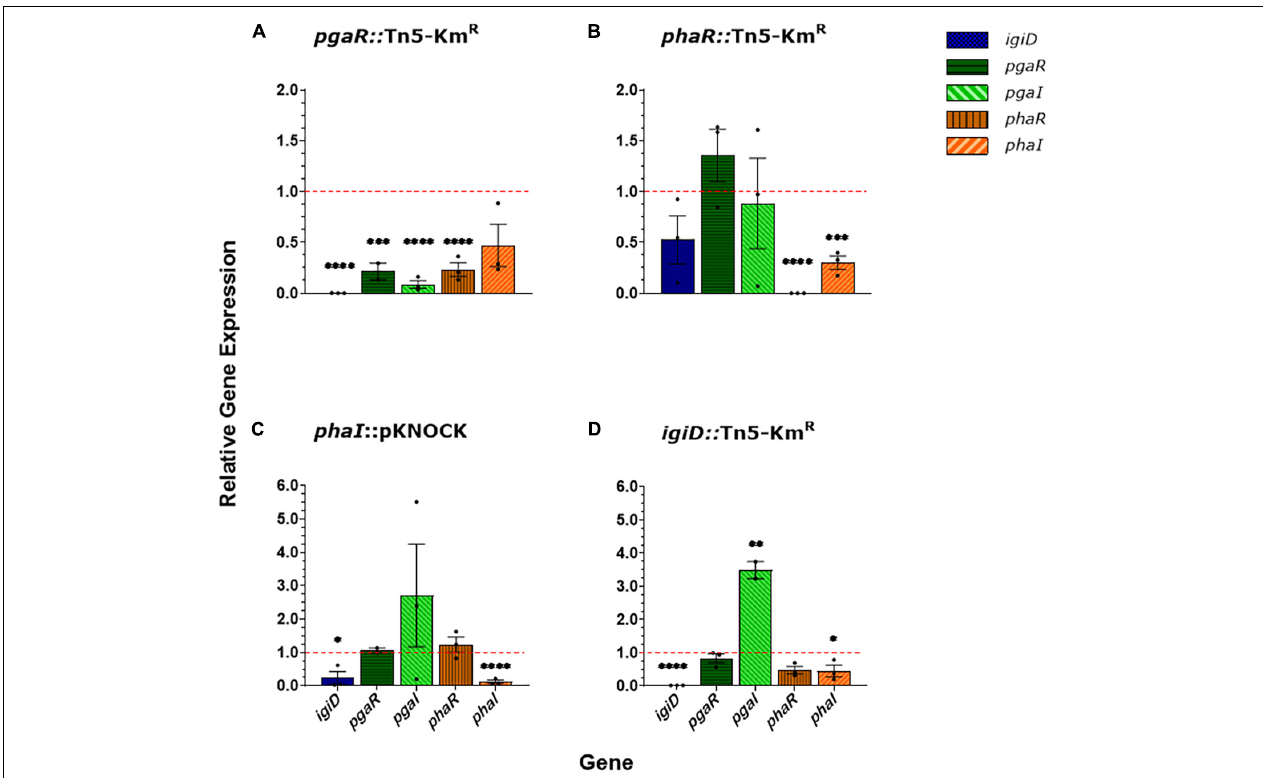
FIGURE 1 | Gene expression of luxRI homologs and igiD synthase from agar grown cultures. Relative gene expression for pgaR ::Tn5-Km R (A) , phaR ::Tn5-Km R (B) , phaI ::pKNOCK (C) , igiD ::Tn5-Km R (D) . Gene expression was normalized to three housekeeping genes ( rpoC , alaS , and map ) and expressed relative to WT, set to 1. Each data point represents the average of three technical replicates and errors bars represent standard deviations between three biological replicates. Statistical significance was calculated using a two-way ANOVA [ p < 0.05 ( ∗ ), 0.01 ( ∗∗ ), 0.001 ( ∗∗∗ ), 0.0001 ( ∗∗∗∗